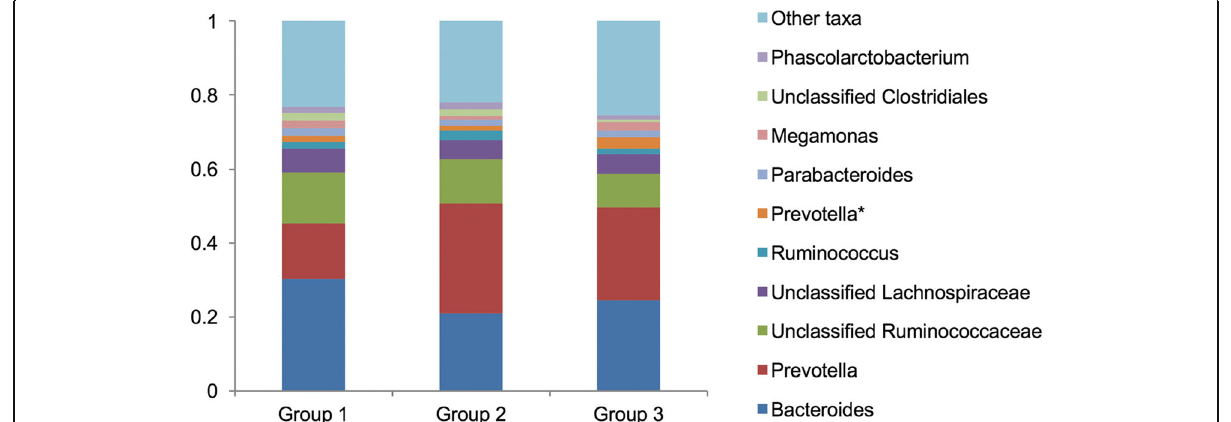
abundance of unclassified Clostridiales was shown the negative trend by groups in Fig. 4c and the taxon was also more abundant in group 2 than group 3 although it was not statistical significant ( p = 0.003, q = 0.18) in (Additional file 1: Table S3). Comparison between groups 1 and 2 + 3 yielded results similar to those ob- tained from the comparison of groups 1 and 2. Quantitative analysis of intestinal 18 F-FDG uptake We also tested whether TBR and TBR were asso- max mean and ciated with changes in gut microbiota. The TBR max TBR showed similar results (Table 3). At the phylum mean level, there was no significant association between TBR and the abundance of individual phyla. At the genus level, abundance of the unclassified Enterobacteriaceae was negatively associated with TBR and TBR max mean respectively) (Fig. 5).